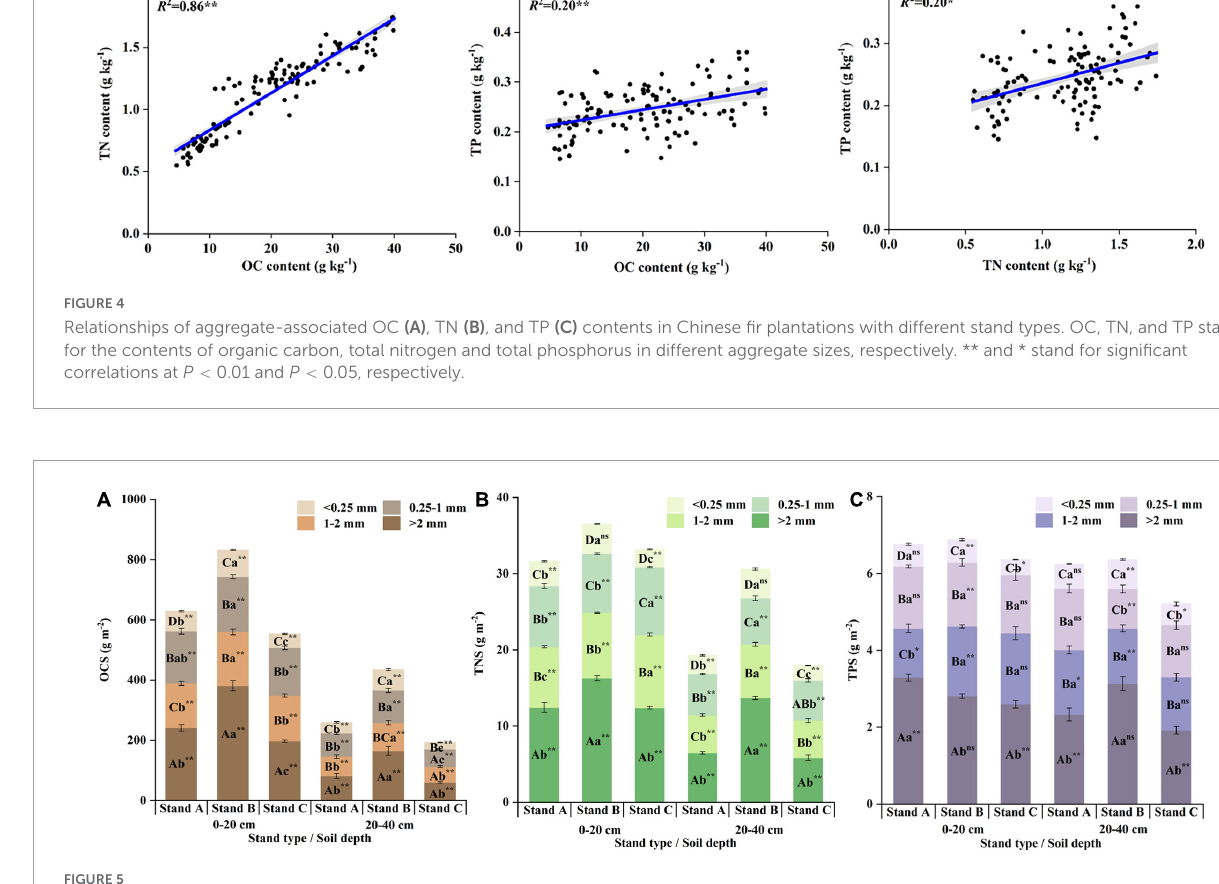
Frontiers in Forests and Global